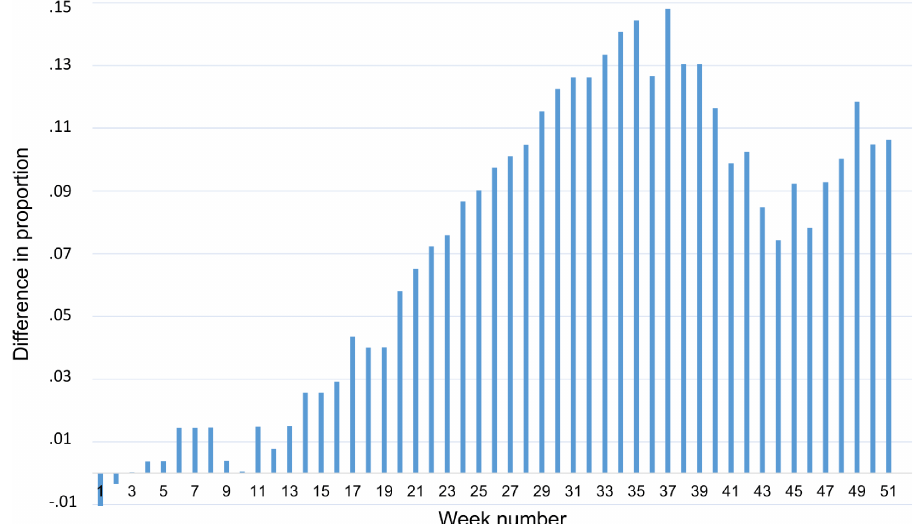
Fig. 3 Difference in Regular Smokers ’ Quitting Behavior in 2020 vs. 2019. Difference of cumulative proportion of quitting behavior for regular smokers in 2020 vs. 2019. Regular smokers in 2019 (2020) are de fi ned as buying an average of at least one cigarette per day in the fi rst ten weeks of 2019 (2020). N =